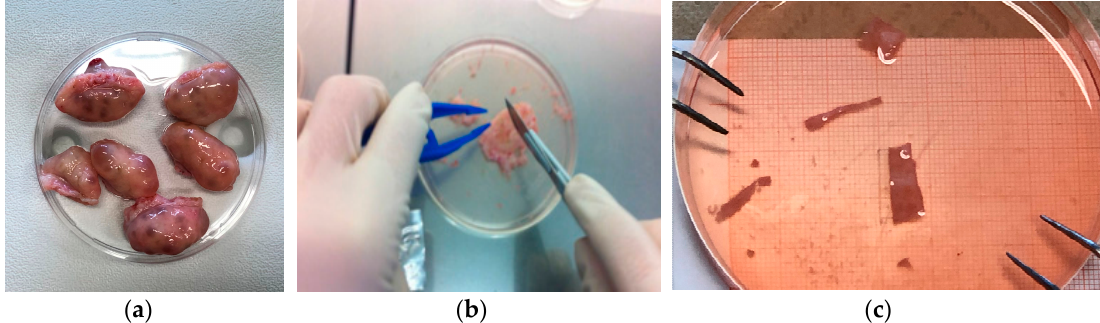
Figure 1. Specimens preparation: ( a ) fresh bovine ovaries; ( b ) fragment dissection; ( c ) tissue fragments.